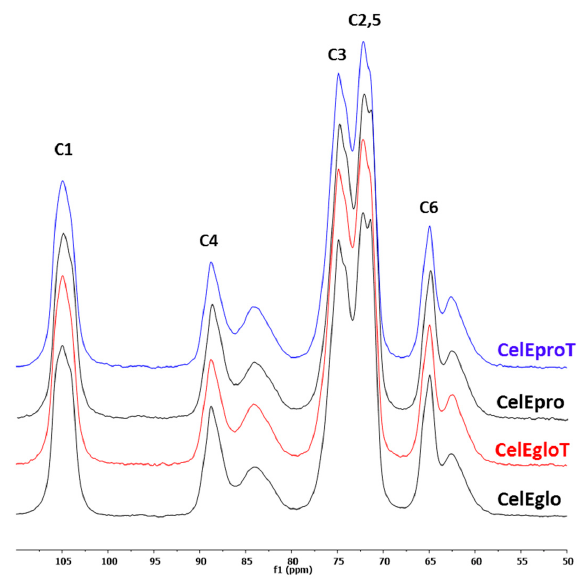
Figure 2. 13 C CP / MAS NMR spectra of cellulose samples isolated from Eucalyptus woods before (Cel Eglo and Cel Epro ) and after (Cel EgloT and Cel EproT ) thermal treatment. Table 3. Crystallinity of the isolated cellulose from Eucalyptus woods assessed by solid-state 13 C NMR, degree of polymerization (DPv) determined by